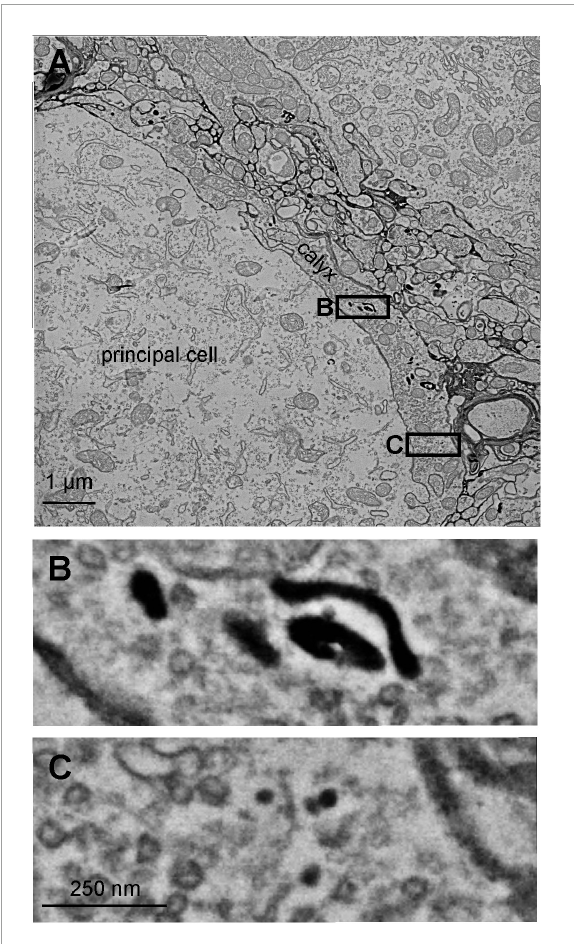
FIGURE1 In vivo application of HRP labels endocytic structures at the calyx of Held synapse. (A) EM image of a P12 calyx of Held surrounded by HRP reaction product. Endocytic compartments are evident in the calyx as well as the MNTB principal cell. (B,C) Higher magnifications from the framed areas in (A) showing large endosomes (B) and bSVs (C) , respectively. Scale bar